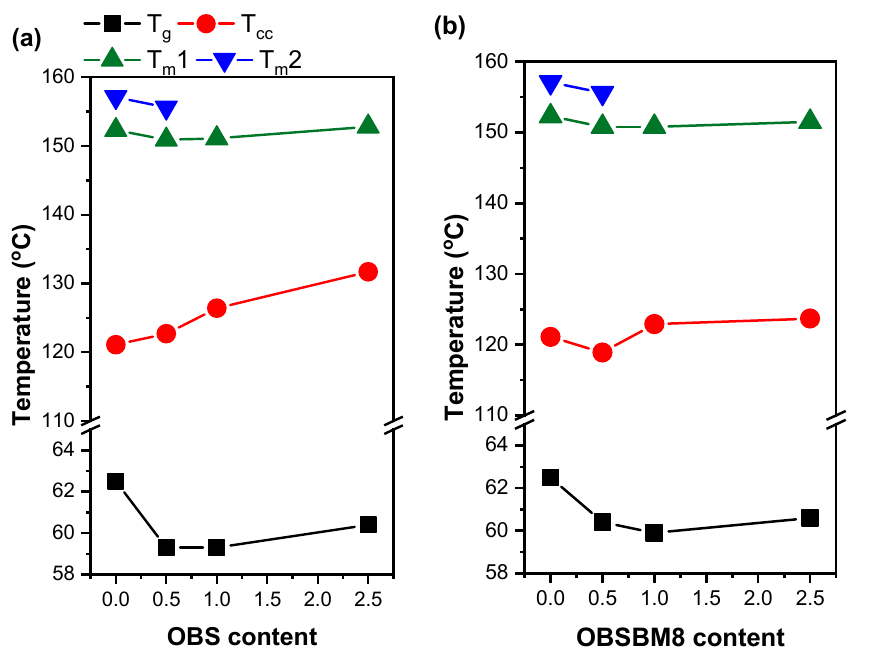
Figure 6. Effect of ( a ) OBS lignin and ( b ) OBSM8 lignin content on the T g , T cc and T m of PLA. XRD patterns of both amorphous films and after annealing at 110 ◦ C for 1 h were recorded. The patterns are shown in Figure 7. Before annealing, the PLA is received amorphous with a typical halo pattern. After annealing, both series of composites show the expected crystalline diffraction peaks at 2 θ = 14.8 ◦ , 16.5 ◦ , 19 ◦ and 22 ◦ , which correspond to the crystal planes (010), (200/110), (203) and (210). The position of the peaks is not al-